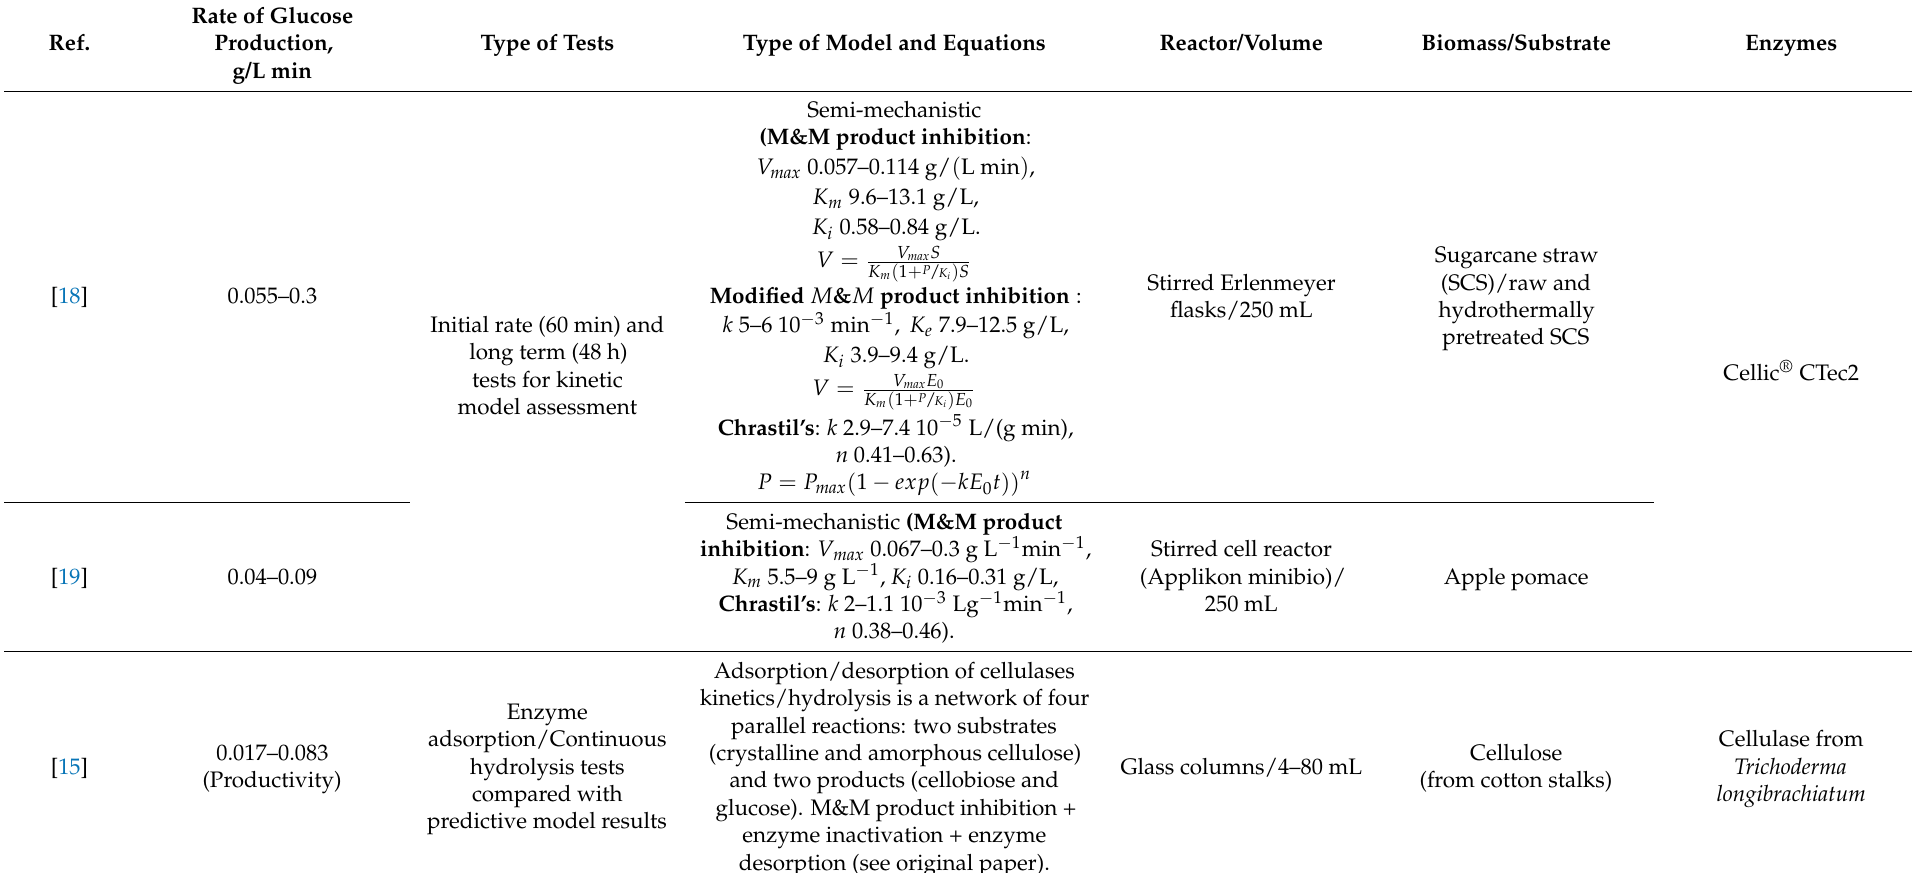
Table 1. Glucose production rate values described by semi-mechanistic